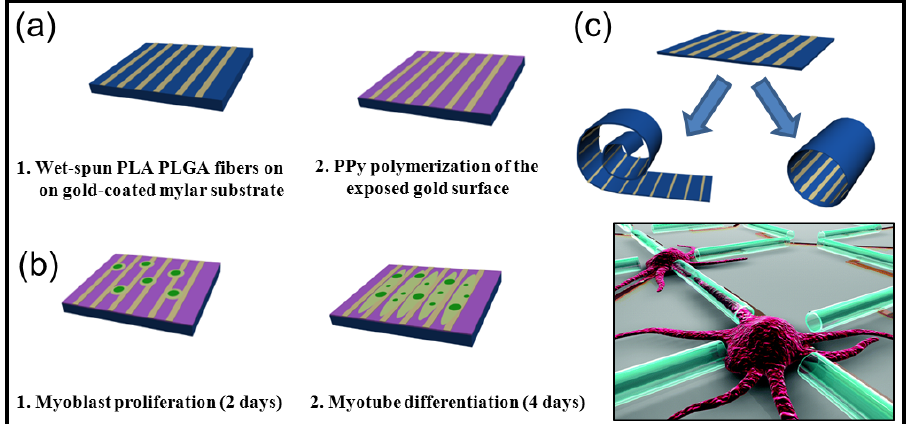
Figure 23. Formation of linear cell-seeded biosynthetic fiber constructs. ( a ) The two-step fabrication of the hybrid platform involved: ( 1 ) wet spinning of PLA:PLGA fibers onto a substrate to create an aligned microfiber array pattern; and ( 2 ) electrochemical deposition on the substrate of the conducting PPy; ( b ) The compatibility of the hybrid platform toward skeletal muscle was assessed by: ( 1 ) Proliferation and adhesion of cells and ( 2 ) Cell differentiation; and ( c ) The hybrid scaffold can be removed from the substrate layer and manipulated into 3D structures for in vivo implantation as required. Reprinted with permission from [100] and [102]. Copyright 2009 WILEY-VCH Verlag GmbH & Co. and 2011 American Chemical